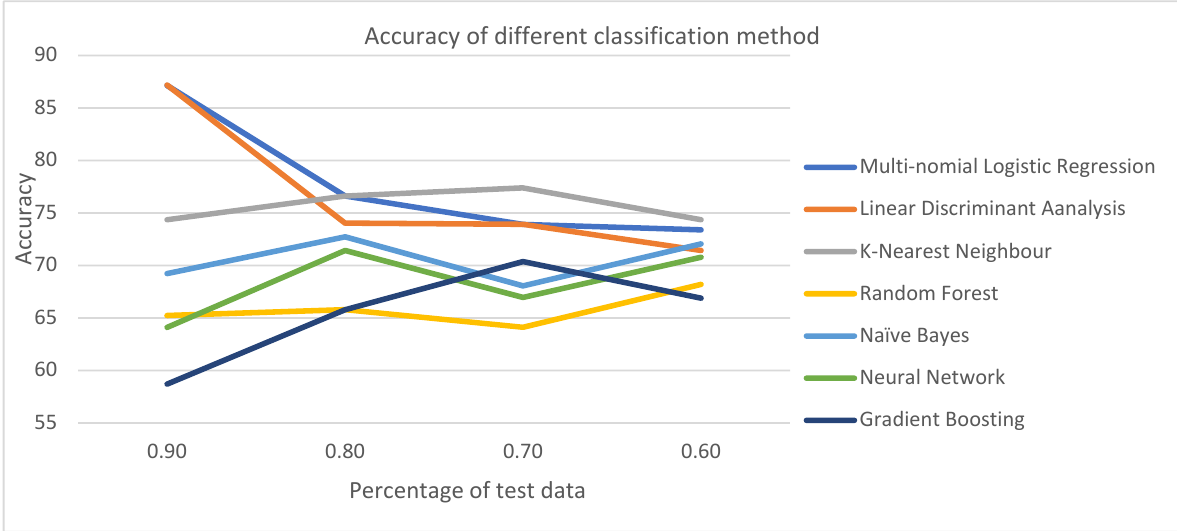
Figure 2. Accuracy of different classification methods for different split ratios.